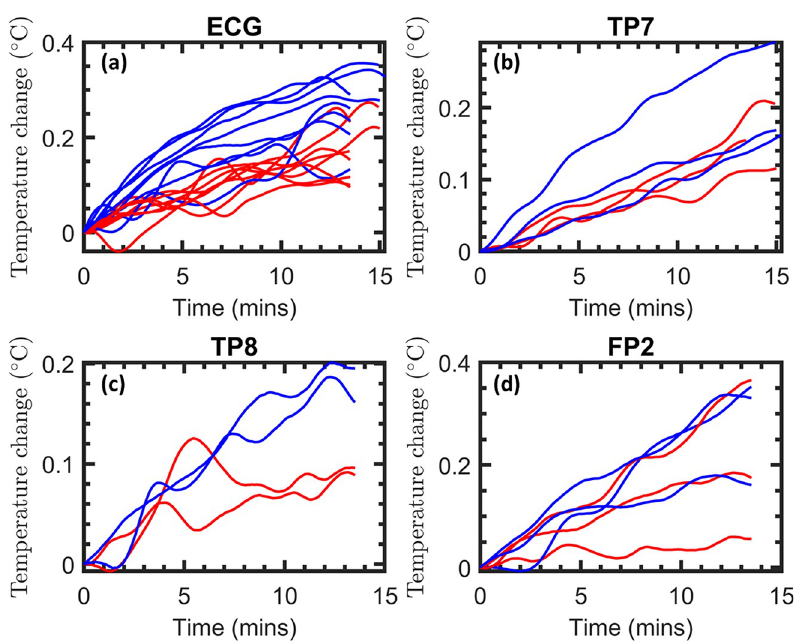
Fig 3. Superposition of the individual temperature measurements in the watermelon “phantom”. Traces from the individual conditions that were recorded consecutively are superimposed for better comparison (MB sequence = red, SB sequence = blue).